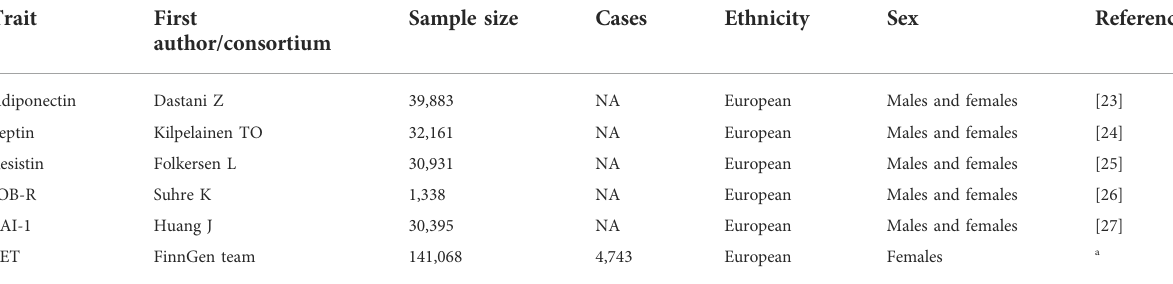
TABLE 1 Basic characteristics for selected summary-level GWASs applied in MR